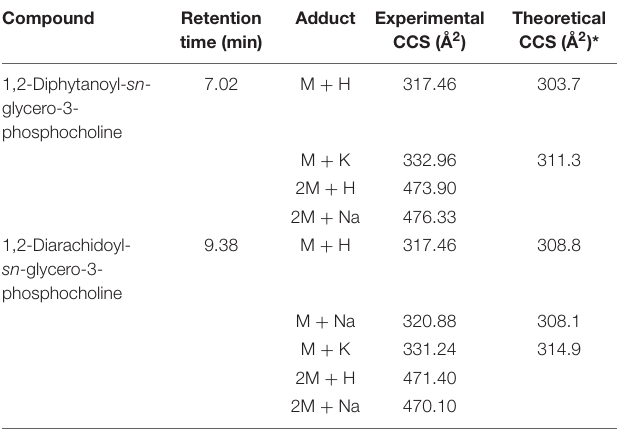
Figure 3 . 20:0 PC was chosen to represent a typical linear eukaryotic lipid, whereas 4ME 16:0 PC was chosen to represent a typical branched isoprenoid diether lipid of archaea. It should be stressed that while the isomeric pair was chosen because of their hydrocarbon chains, the bond angle of ether and ester linkages are not identical, ether lipids are slightly larger than ester lipids with the same mass 1